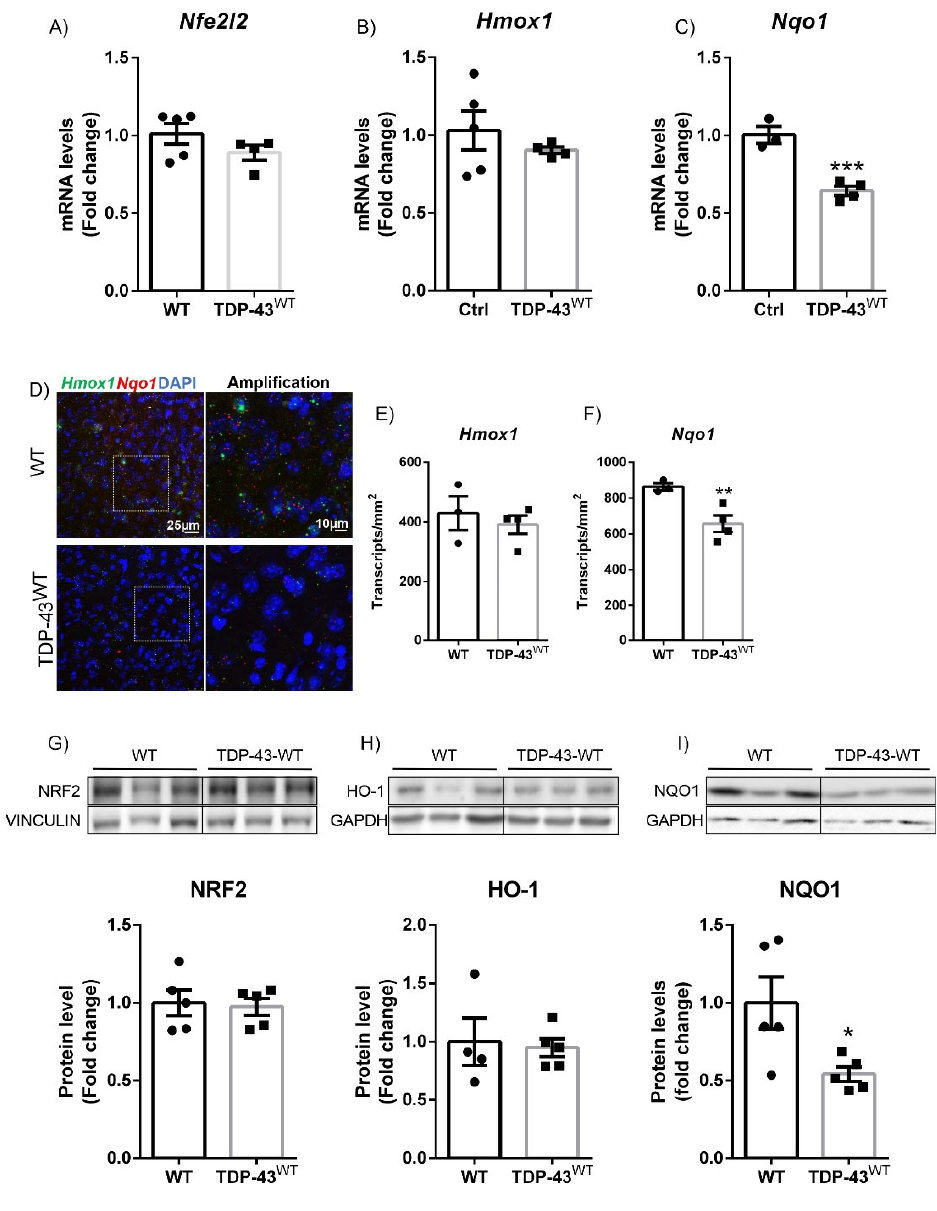
Figure 1. TDP-43-dependent FTLD transgenic mouse model showed decreased NQO1 expression in the prefrontal cortex. Quantitative real-time PCR determination of mRNA levels of ( A ) Nfe2l2 , ( B ) Hmox1 , and ( C ) Nqo1 . All genes were normalized by Tbp (TATA box binding protein) mRNA levels; n = 4–5 samples ± SEM. Asterisks denote significant differences at *** p < 0.001 when comparing the indicated group to the wild ‐ type mice according to the Student’s t ‐ test. ( D ) RNAscope ISH labelling of Hmox1 (green) and Nqo1 (red) in prefrontal cortex of 90 ‐ day ‐ old CaMKII ‐ TDP ‐ 43 ‐ WT mice. Quan ‐ tification of ( E ) Hmox1 and ( F ) Nqo1 expression using Fiji analysis. Asterisks show significant differ ‐ ences at ** p < 0.01 when comparing groups according to the Student’s t ‐ test. Protein levels of ( G ) NRF2, ( H ) HO ‐ 1, and ( I ) NQO1 were analyzed by immunoblotting and their respective protein